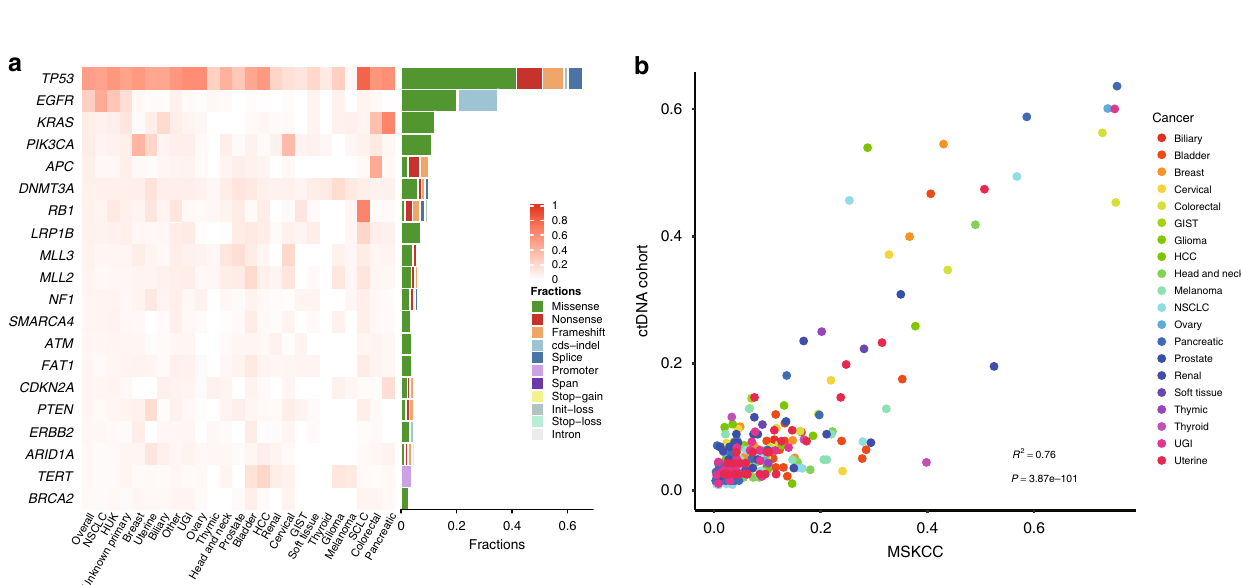
Fig. 3 Mutational landscape revealed by ctDNA pro fi ling. a Heatmap illustrating the top 20 most common mutant genes. Color gradation represents the mutational prevalence of each gene in different cancer types. The right bars indicate the distribution of different mutational types for each displayed gene. b Mutational prevalence of driver genes in our ctDNA and MSKCC cohorts. Putative driver genes in different cancer types are displayed. Symbol colors correspond to different cancer types. The statistical test used is two-tailed Pearson correlation test. GIST gastrointestinal stromal tumor, HCC hepatocellular carcinoma, NSCLC non-small cell lung cancer, SCLC small cell lung cancer, UGI upper gastrointestinal